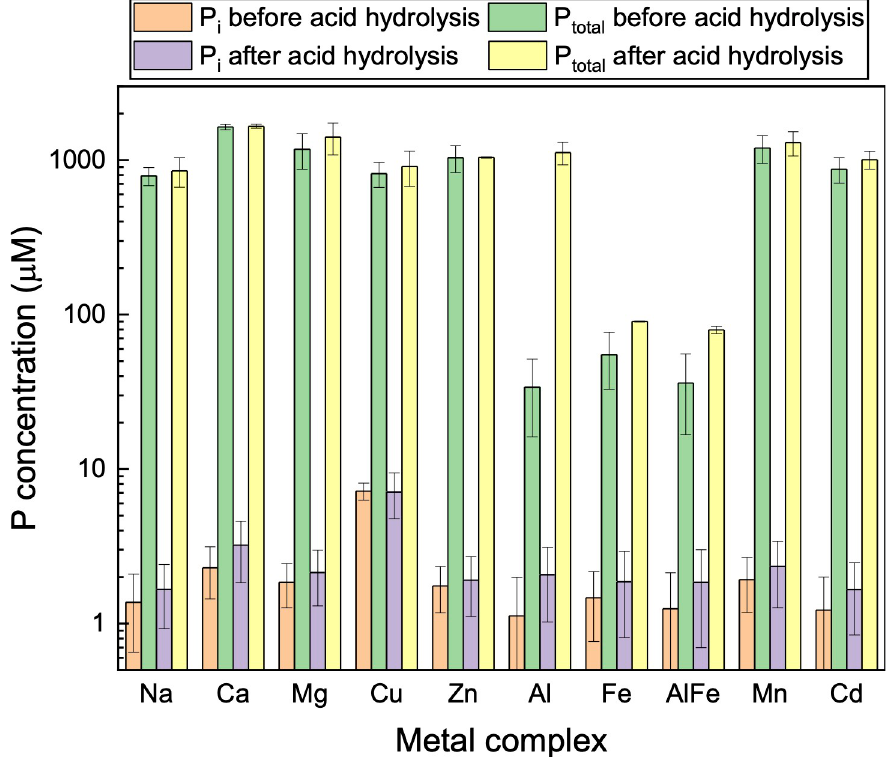
Fig 5. Stability of metal phytate complexes in acid (1 M HCl). P i and P total before acid hydrolysis refer to that already present in the solution before treatment. The initial concentration of metal phytate complex in the solution was 300 mg/L in each experiment. The difference of soluble phytate P before and after hydrolysis is